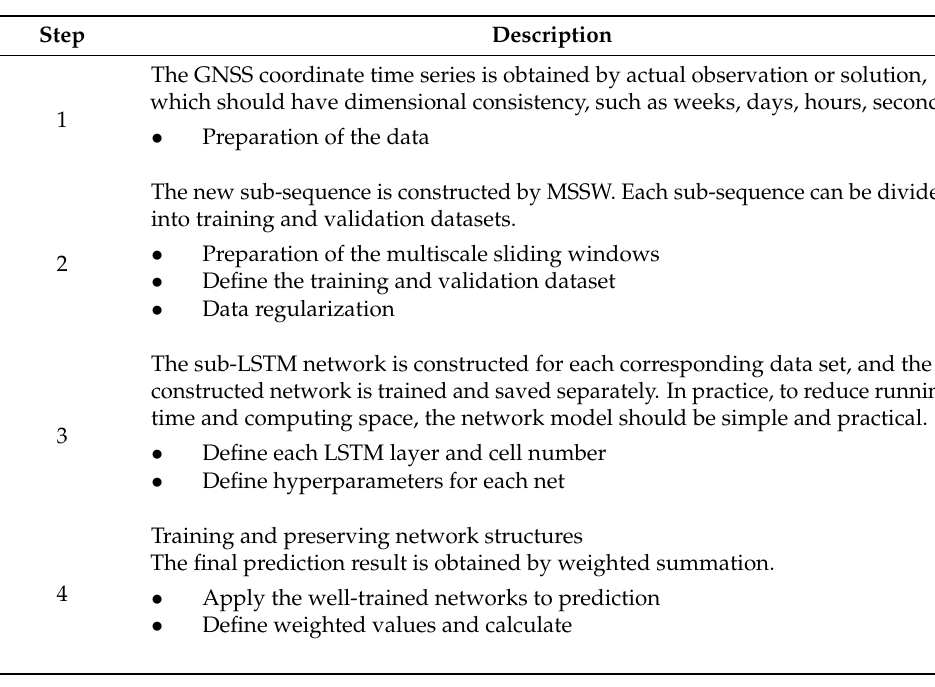
Table 1. Training the MSSW-LSTM